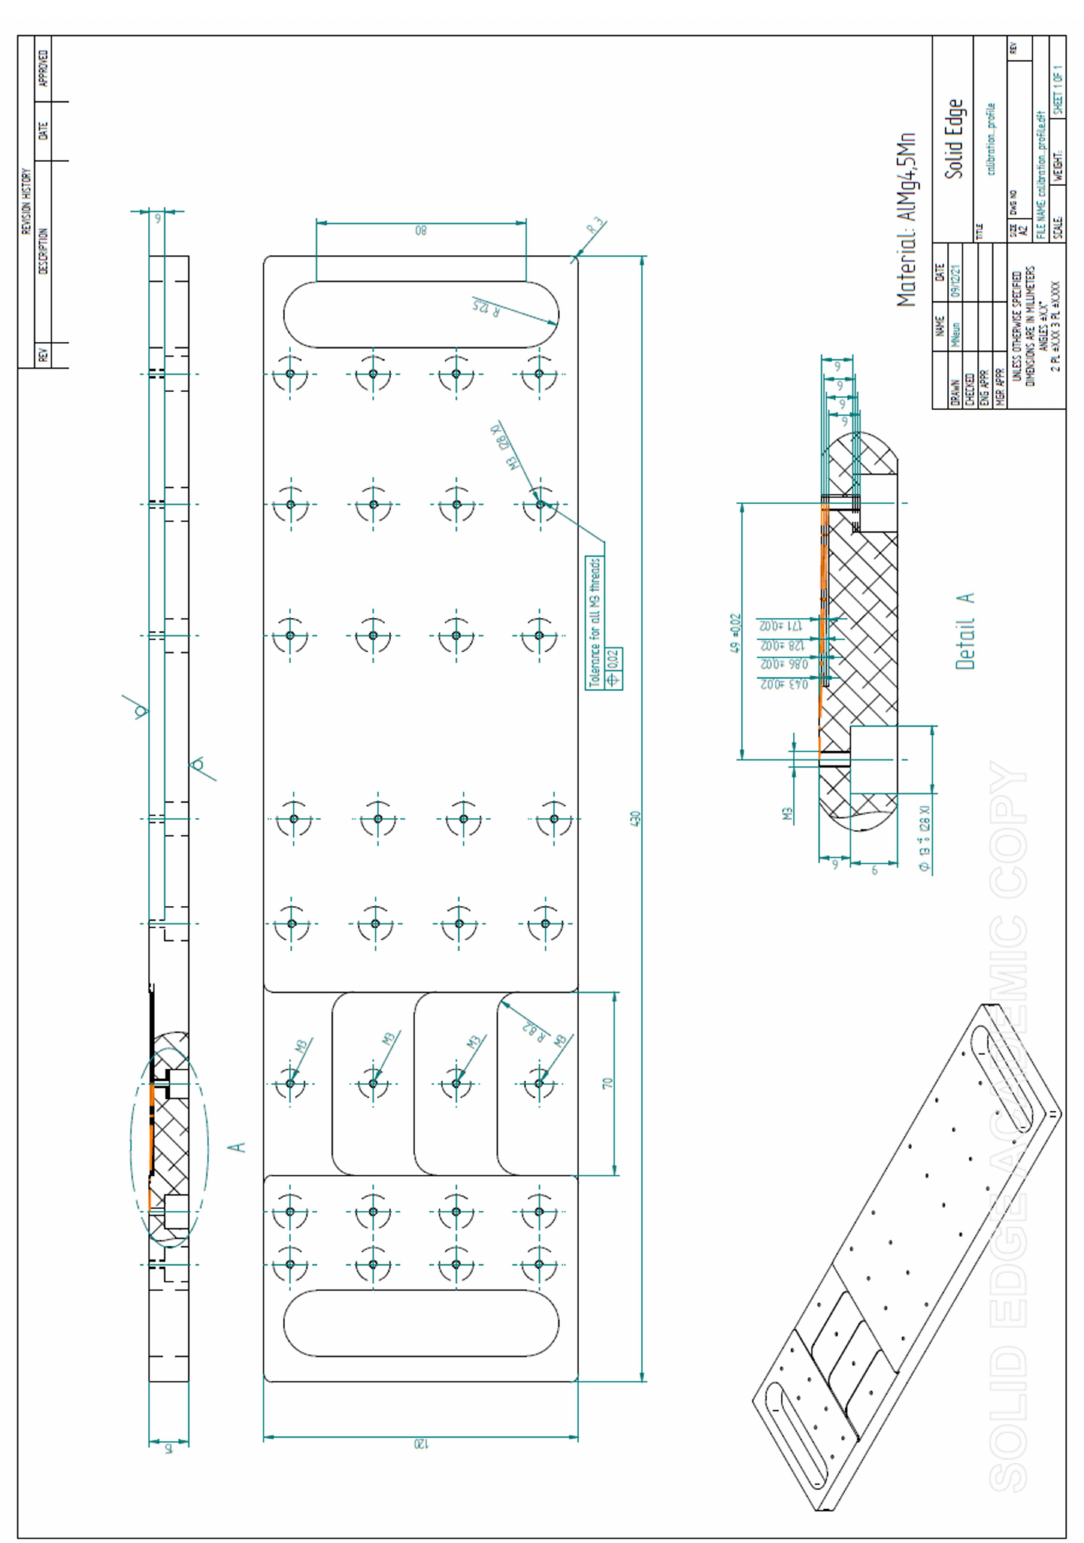
Figure A1. Construction drawing of the calibration